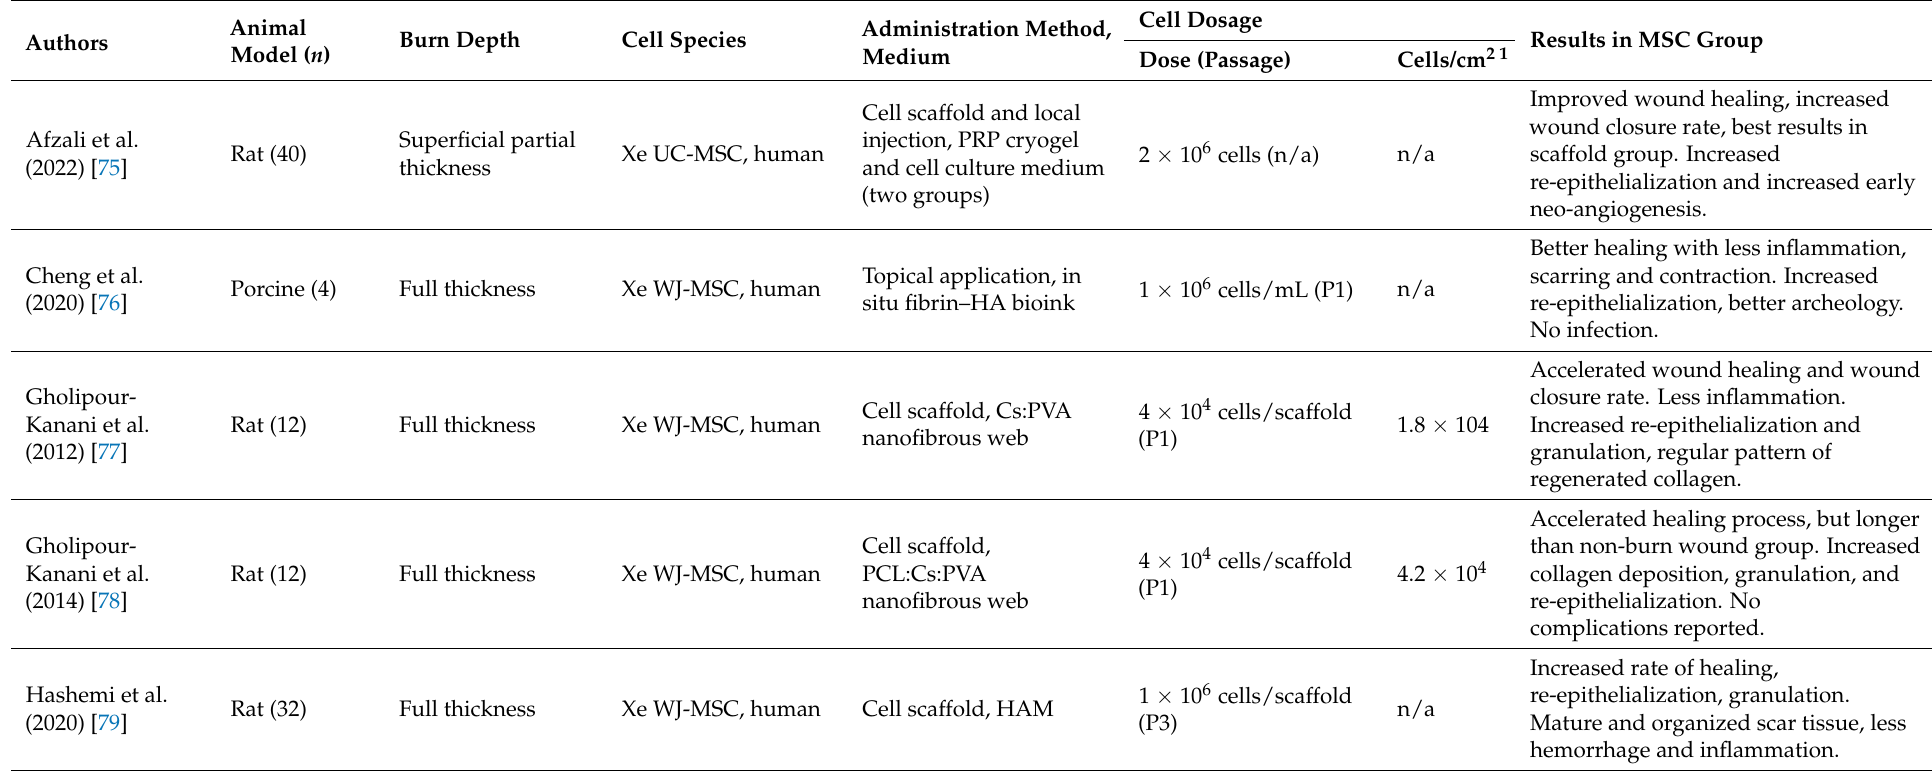
Table 5. Characteristics of studies included—preclinical studies using Wharton’s-Jelly- or umbilical-cord-derived MSCs ( n =